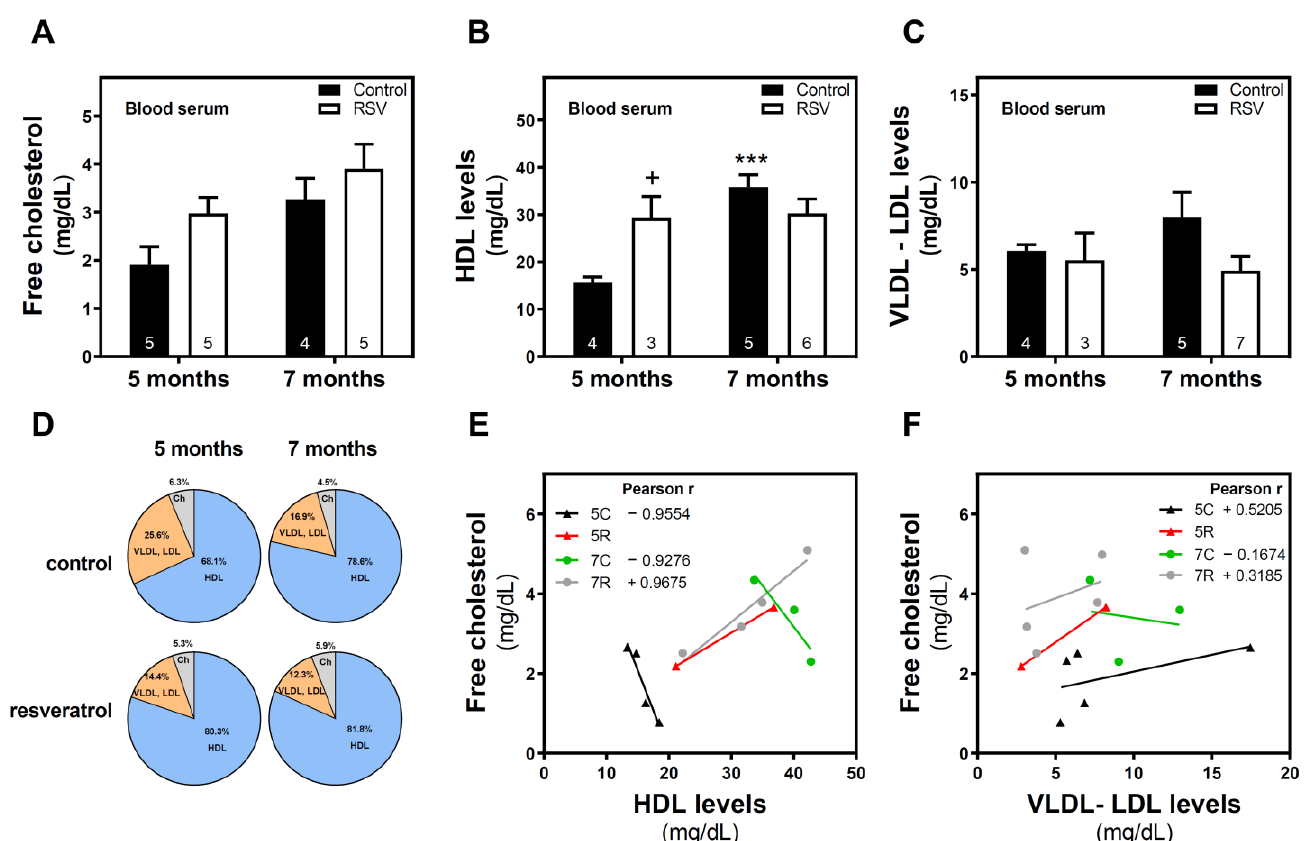
Figure 6. Levels of free cholesterol and related-lipoproteins in blood serum of SAMP8 mice. Quan- tification of free-cholesterol ( A ) together with their related lipoproteins HDL ( B ) and VLDL-LDL ( C ) were carried out by following the kit manufacturer’s protocol. Relative contribution of free cholesterol, HDL, and VLDL-LDL lipoproteins to the global amount of cholesterol ( D ). HDL ( E ) and VLDL-LDL ( F ) levels were correlated with free cholesterol levels from blood serum. Data are the mean ± SEM of the indicated different samples. Two-way ANOVA and a Sidak test for multiple comparisons were applied. *** p < 0.001: significantly different from the corresponding 5 mo value; + p < 0.05: significantly different from the corresponding control group. Pearson correlation was applied for correlation analysis.